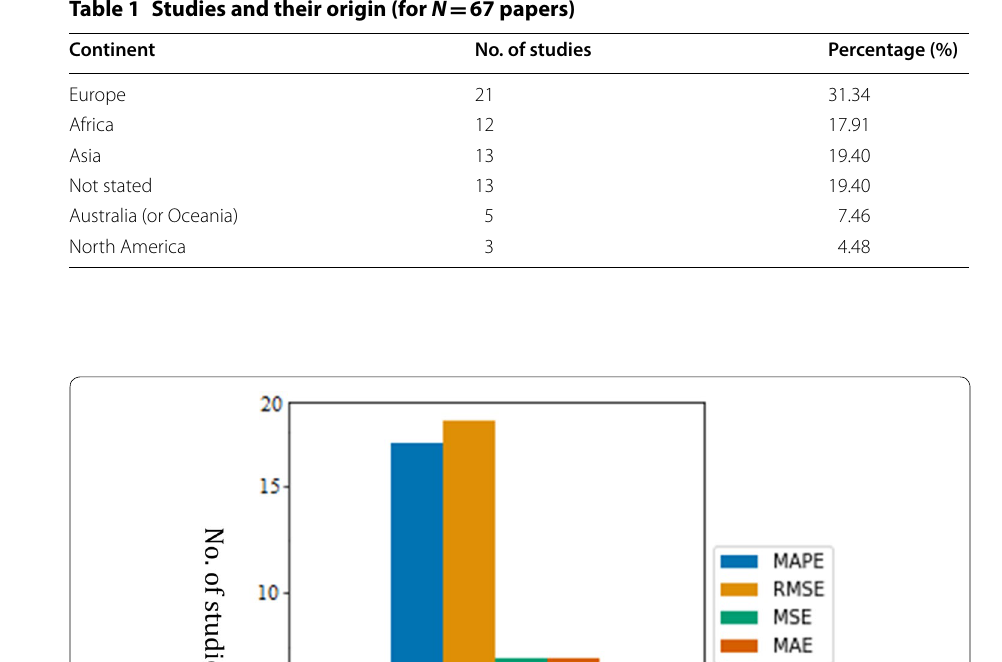
Table 1 Studies and their origin (for N